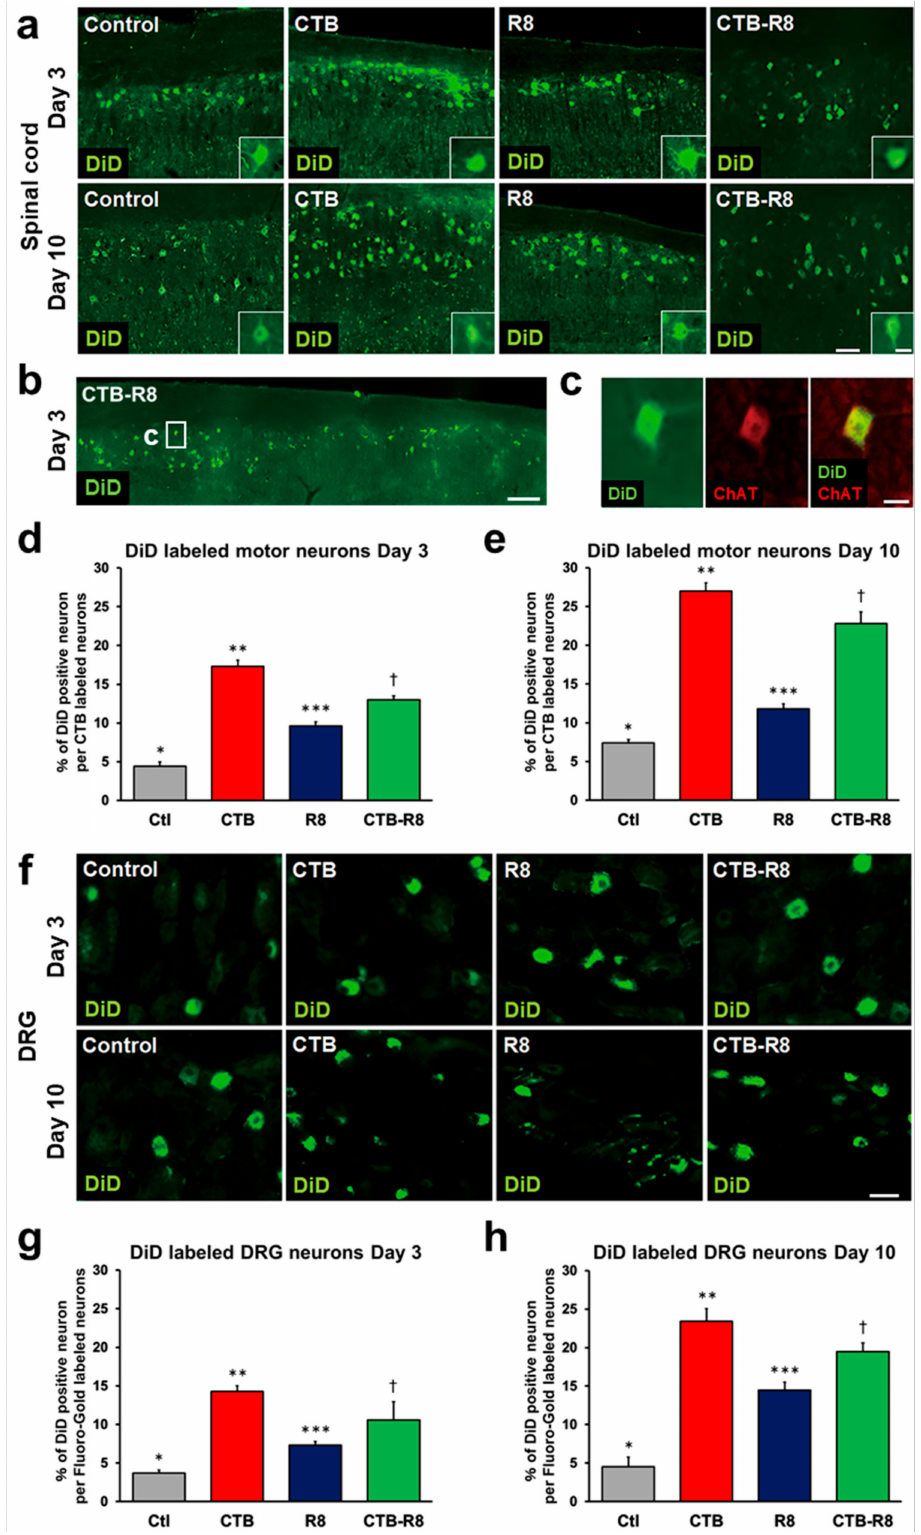
Figure 5. Retrograde transport of liposomes modified with CTB and R8 to spinal cord motor neurons and DRG neurons 3 and 10 days after sciatic nerve injection. ( a ) Horizontal sections of the lumbar spinal cord 3 and 10 days after sciatic nerve injections. Rostral is left. Motor neurons receiving retrogradely transported liposomes were identified by DiD fluorescence. Insets are high-magnification views of DiD-labeled motor neurons. Scale bars, 100 µ m, 30 µ m (inset). ( b ) Lower-magnification